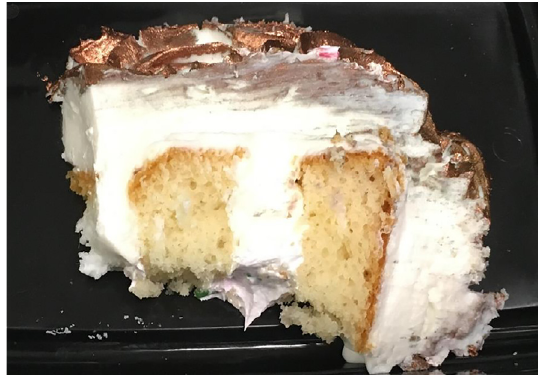
Image 2. Slice of birthday cake with rose-gold luster dust frosting, the consumption of which led to copper toxicity.